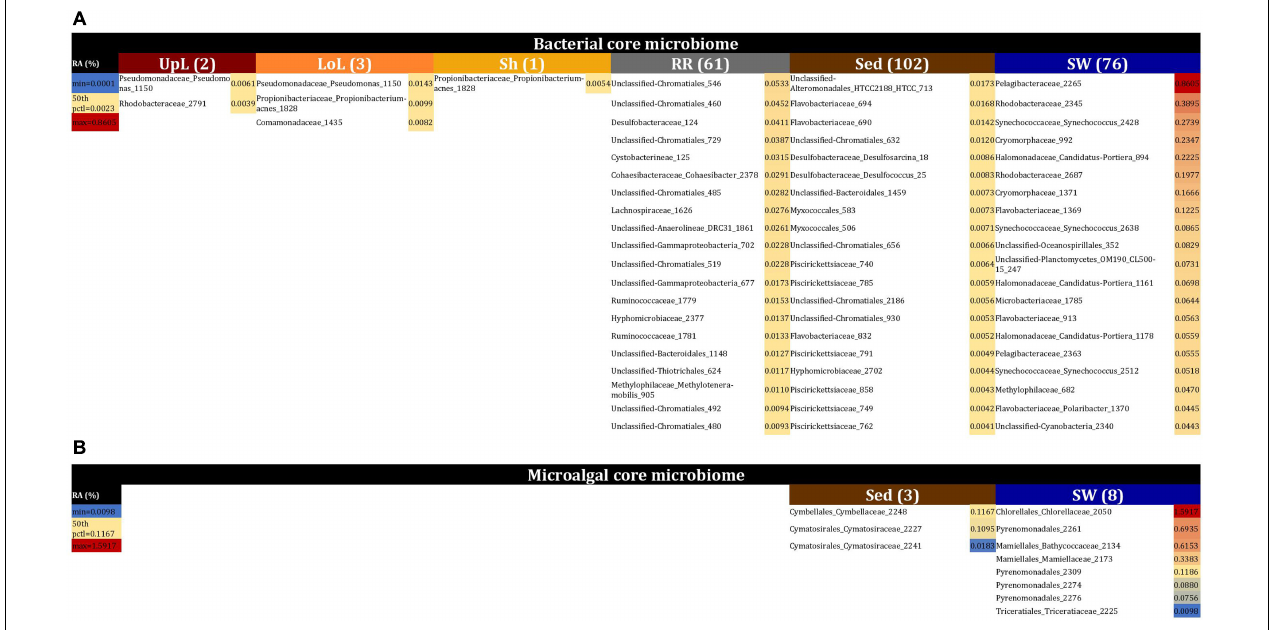
FIGURE 6 | The seagrass core microbiomes. Bacterial (A) and microalgal (B) core OTUs associated with the seagrass and surrounding microenvironments were identified based on their predominance (i.e., occurrence ≥ 67%, relative abundance > 0%) across the four sampling sites. Cores are listed under columns for each microenvironment, and their sizes are shown in brackets. Core OTUs were identified at the family (bacteria) and order (microalgae) levels and are colored by their relative abundance within each microenvironment. Abundant pelagic microbes were removed from the phyllosphere core microbiomes, and only the 20 most abundant bacterial core OTUs within each microenvironment are plotted to help remove visual clutter. The full version of the table is provided in Supplementary Table 4 . UpL, upper leaf; LoL, lower leaf; Sh, sheath; RR, roots and rhizomes; Sed, sediment; SW, seawater; RA, relative abundance.